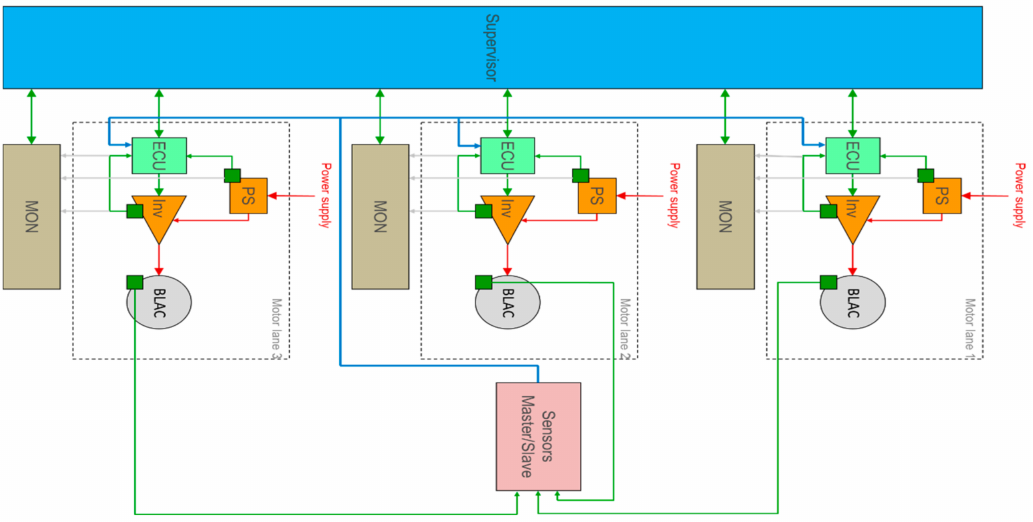
Figure 17. Master / slave